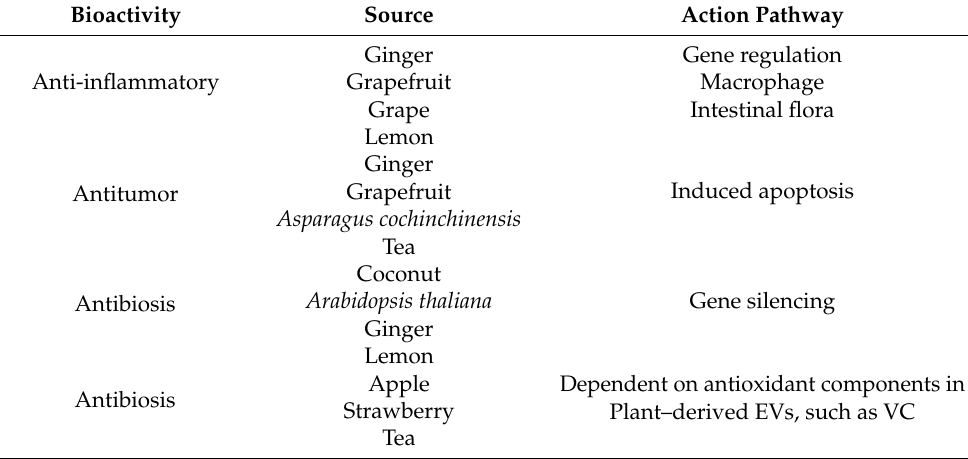
Table 3. The Bioactivity and Action Pathway of Multiple Plant derived